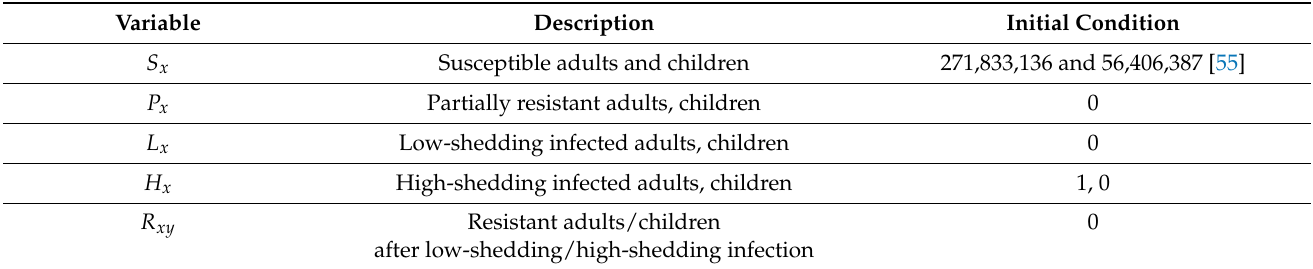
Table 1. State Variables for the Full Model.